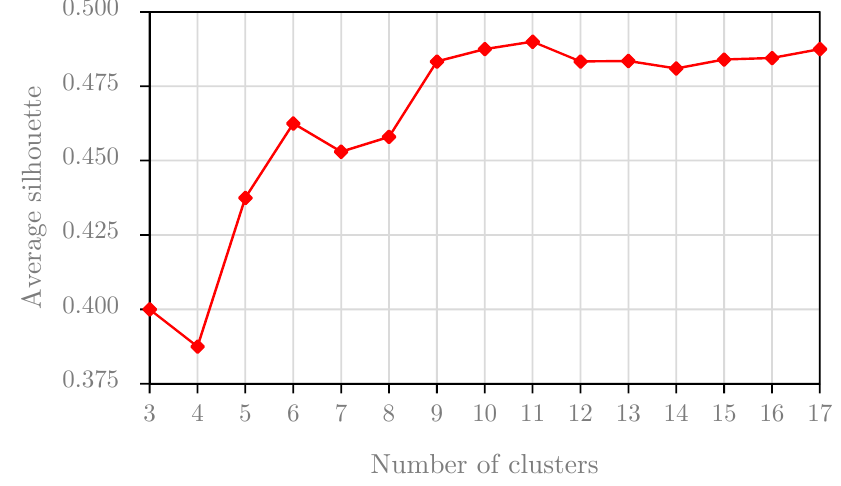
Figure 7. The average silhouette score per number of clusters for the B1 dataset.